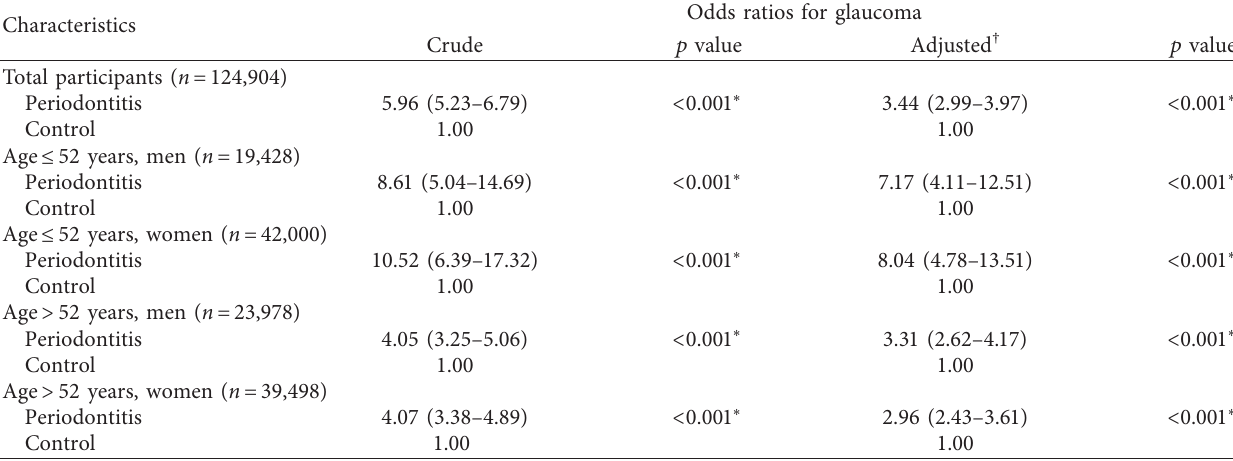
Table 2: Crude and adjusted odds ratios (95% confidence interval) of periodontitis as a risk factor for glaucoma. Characteristics